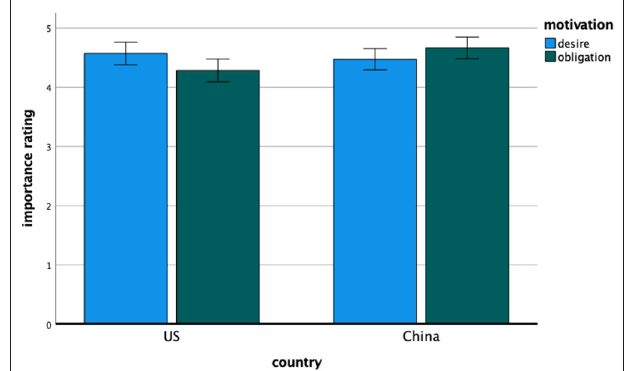
FIGURE 2 | Study 1—the importance ratings of desire and obligation motivation for American and Chinese participants. Error bars denote 95% confidence intervals of the